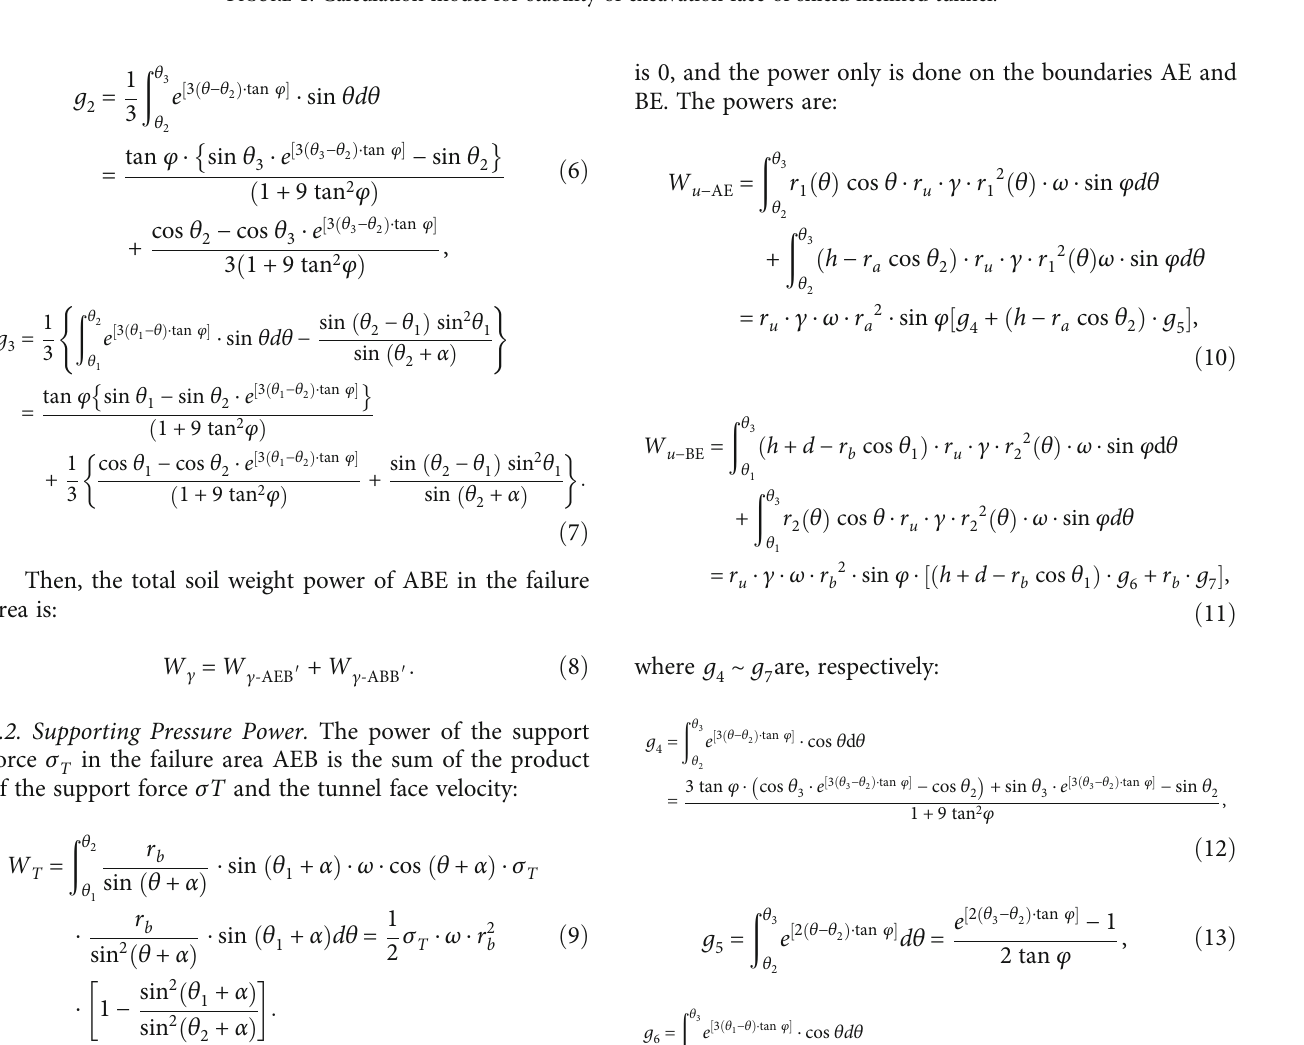
Figure 1: Calculation model for stability of excavation face of shield inclined